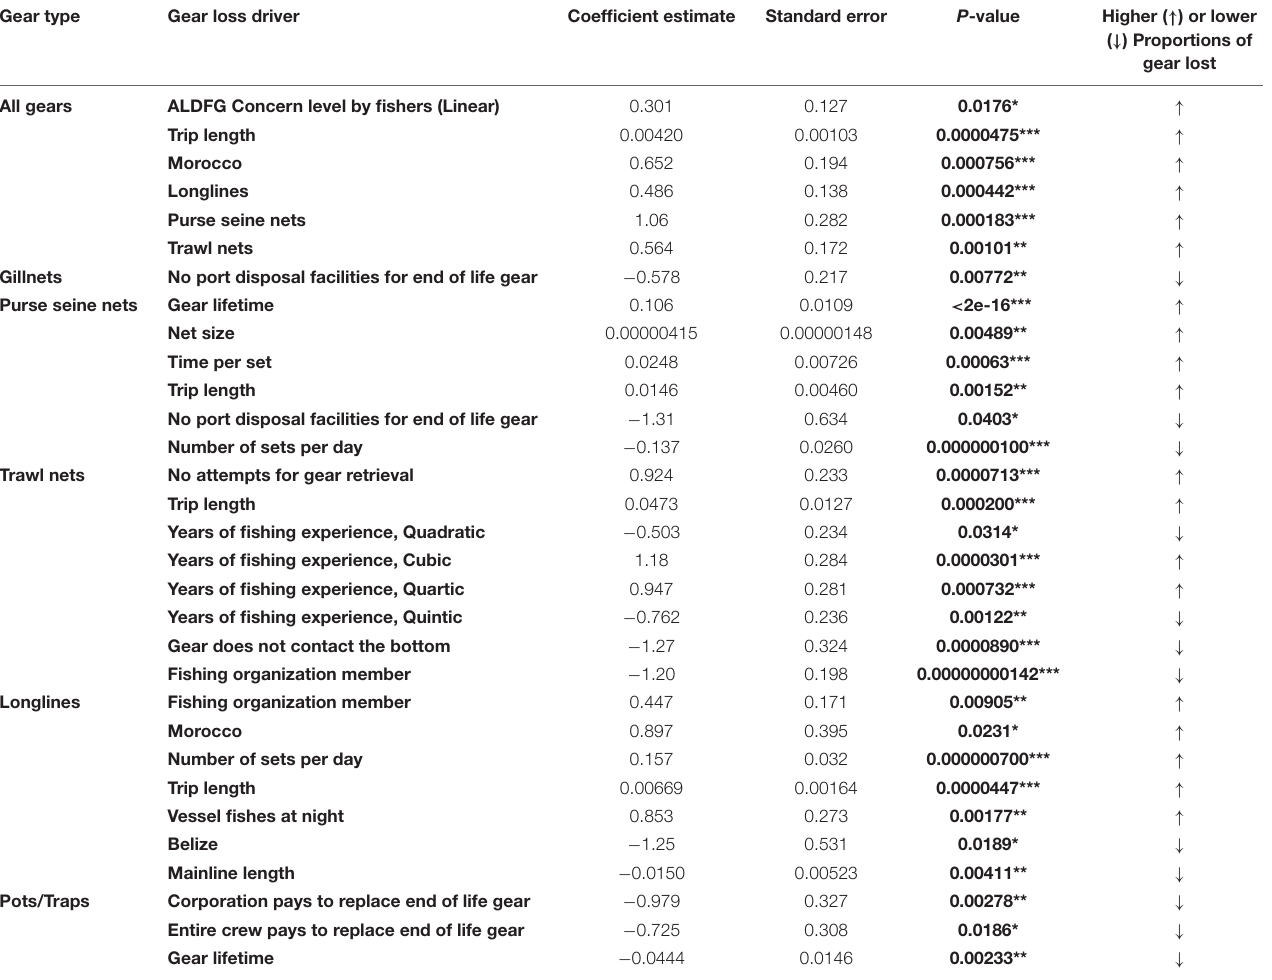
TABLE 2 | Summary of drivers of gillnet, purse seine net, trawl net, longline and pot and trap losses across Belize, Iceland, Indonesia, Morocco, New Zealand, Peru and the United States of America. Gear